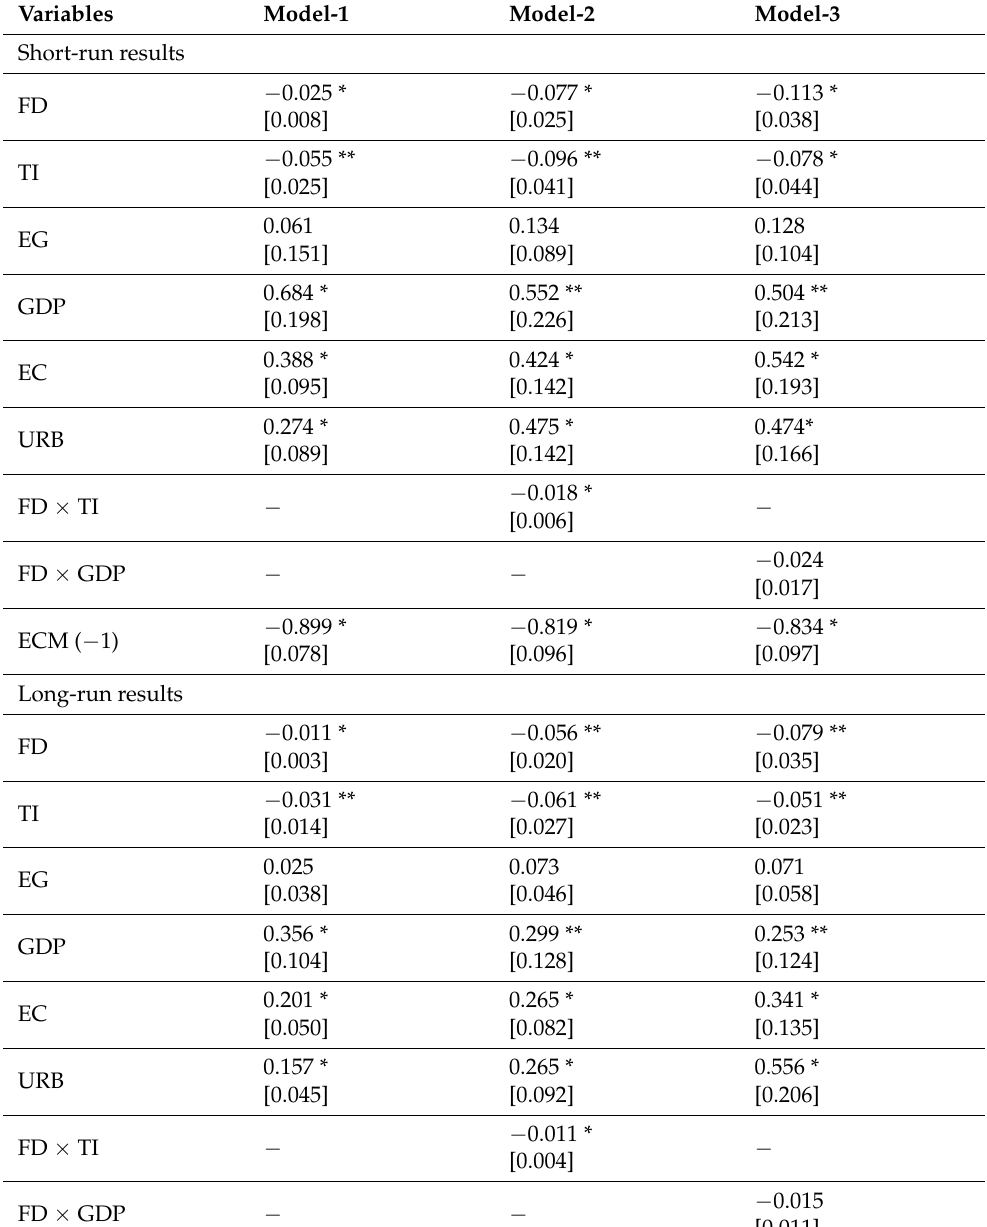
Table 6. Results of